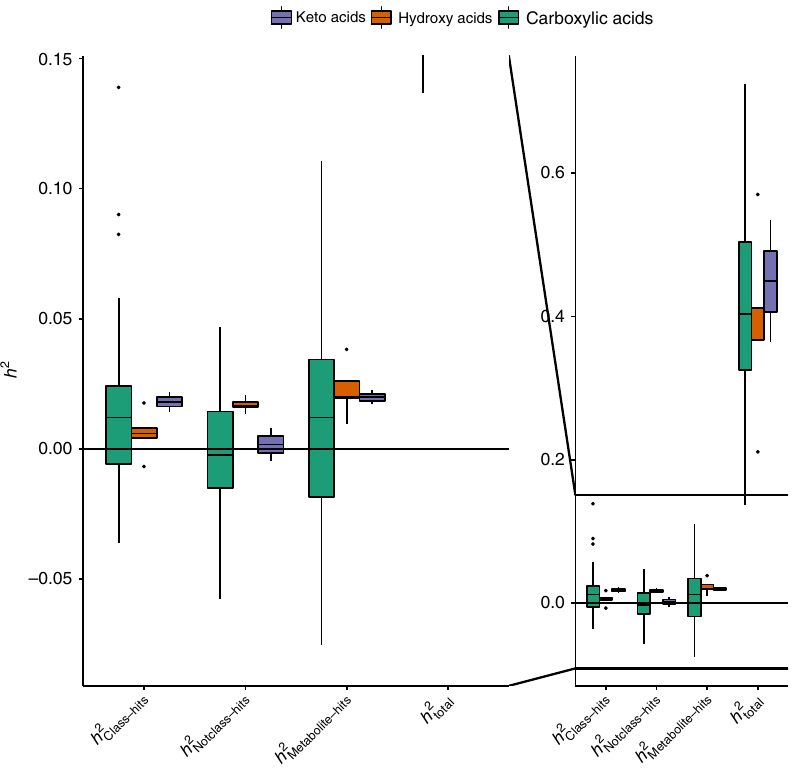
Fig. 2 Heritability of all 52 carboxylic acids by class. Box- and dotplots of the h 2 total , and h 2 Metabolite-hits for all 52 successfully analyzed carboxylic acids and derivatives across all metabolomics platforms by class. The left-hand side of the fi gure is a close-up of the − 0.08 to 0.15 part of the heritability range, focusing on the h 2 Class-hits and h 2 Notclass-hits estimates. The boxes denote the 25th and 75th percentile (bottom and top of box), and median value (horizontal band inside box). The whiskers indicate the values observed within up to 1.5 times the interquartile range above and below the box. The purple, orange and green boxes denote the keto acid, hydroxyl acid and carboxylic acid classes, respectively. Supplementary Data 3 provides the estimates for each of the individual metabolites.